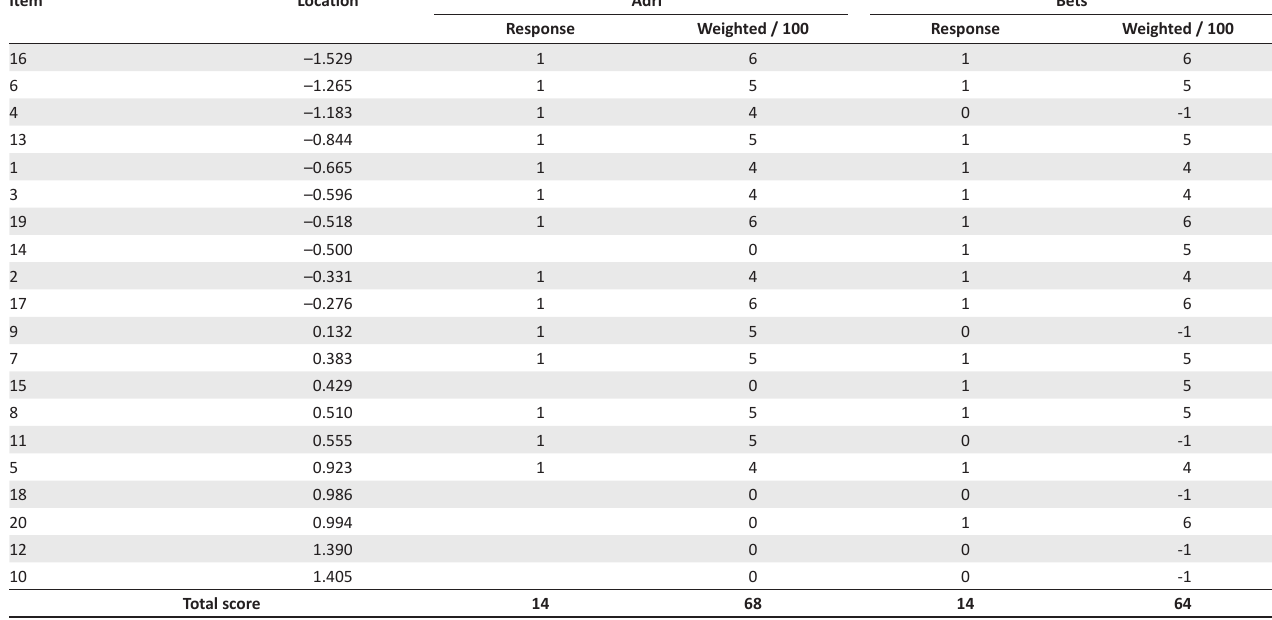
TABLE 13: Item comparison of two contestants with a common score 14 (70 %